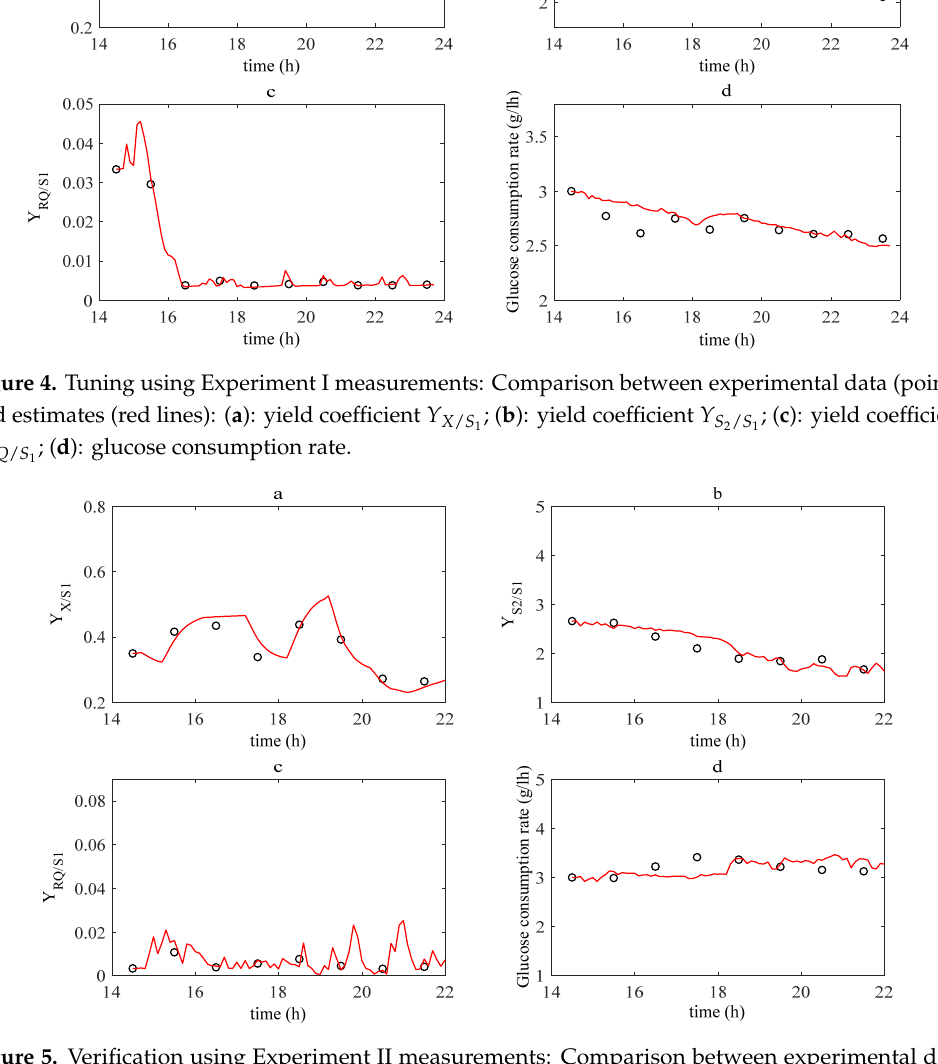
Figure 5. Verification using Experiment II measurements: Comparison between experimental data (points) and estimates (red lines). ( a ): yield coe ffi cient Y X / S ; ( b ): yield coe ffi cient Y S ; ( c ): yield 1 2 / S 1 coe ffi cient Y RQ / S ; ( d ): glucose consumption 1